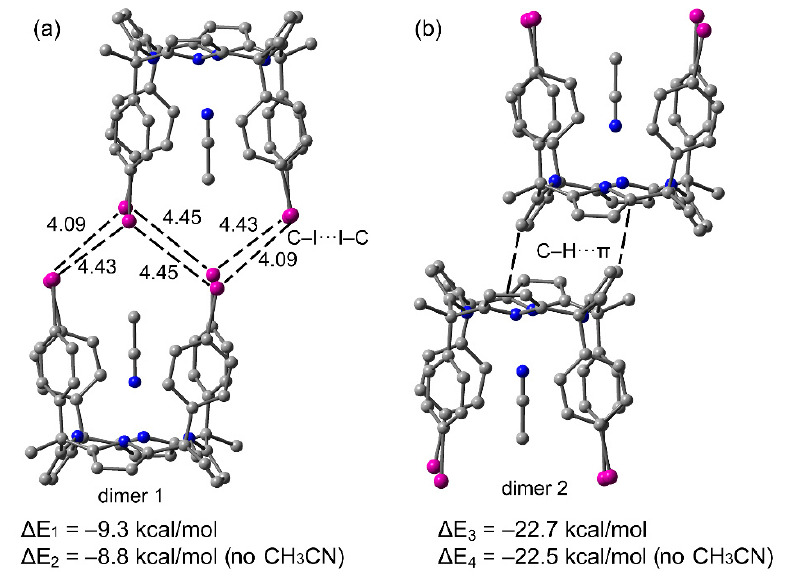
Figure 6. Two supramolecular dimers retrieved from the X-ray structure of polymorph B . Distances Å ( a ) dimer 1; ( b ) dimer in Å.